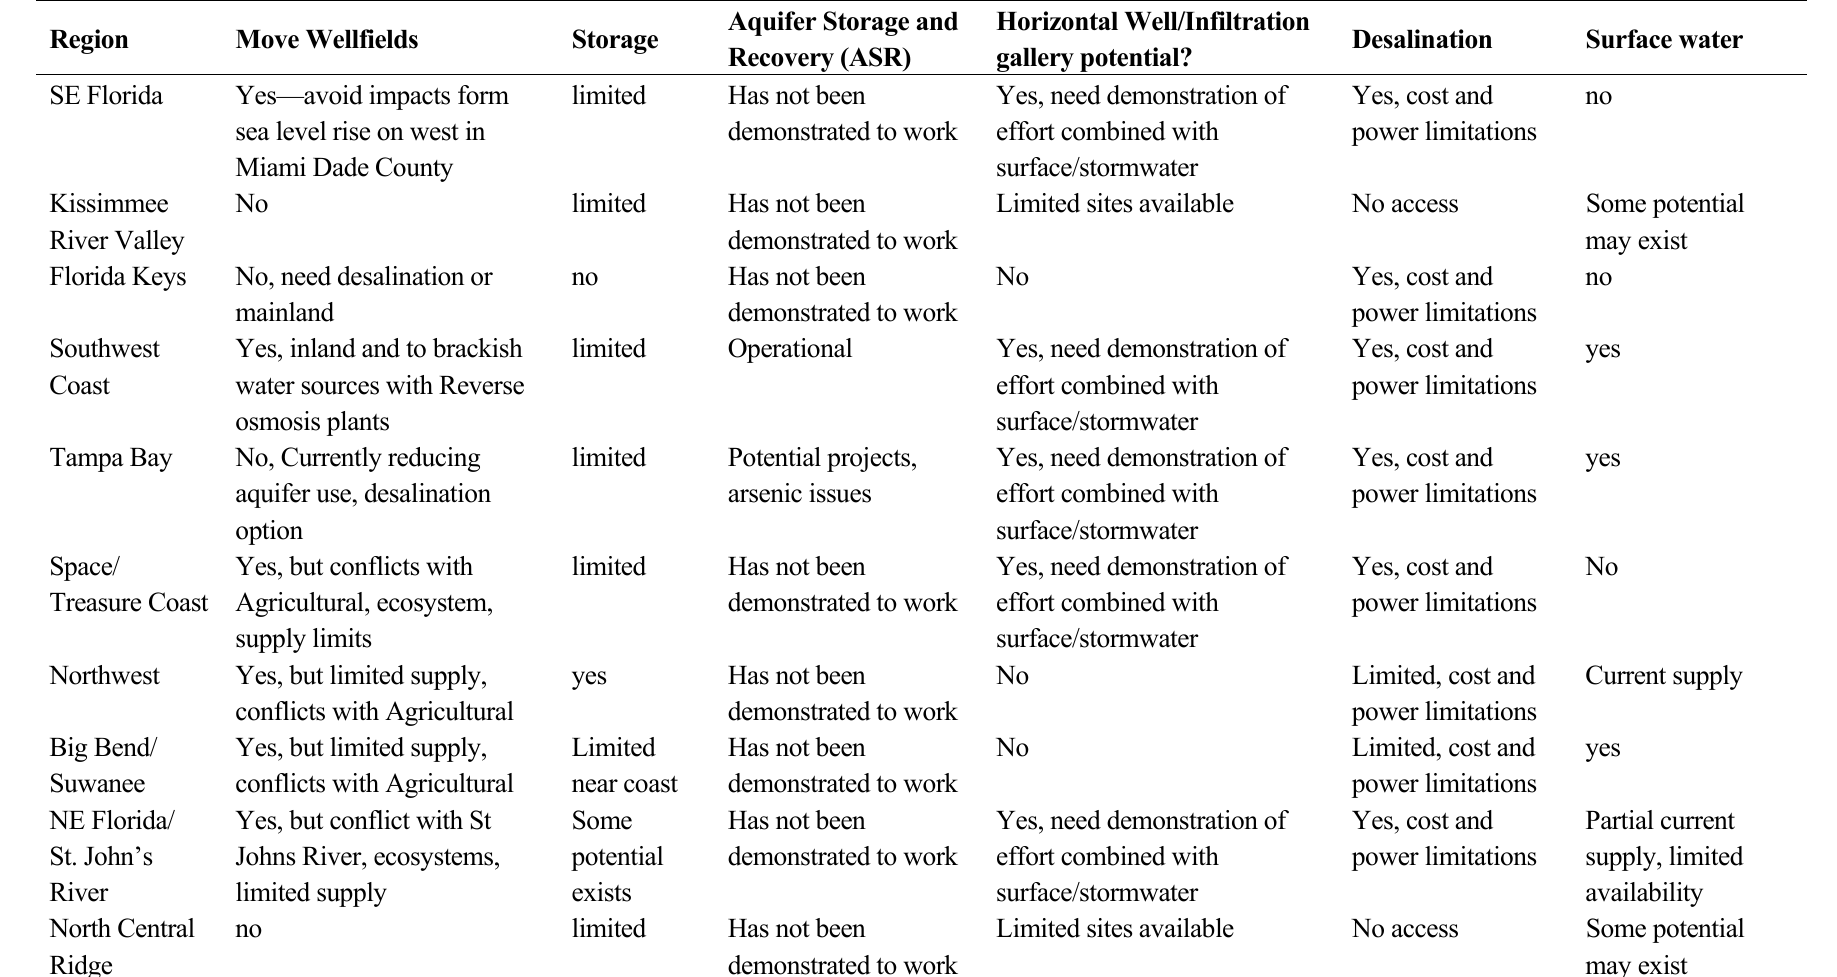
Table 3. Water supply options/alternative water supply